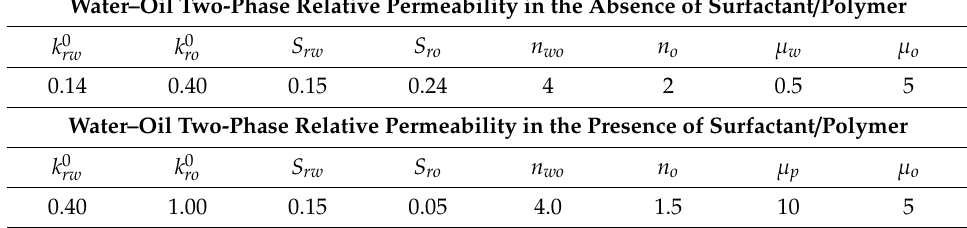
Table 4. Corey model parameters for water–oil two-phase relative permeability in the presence and absence of surfactant and